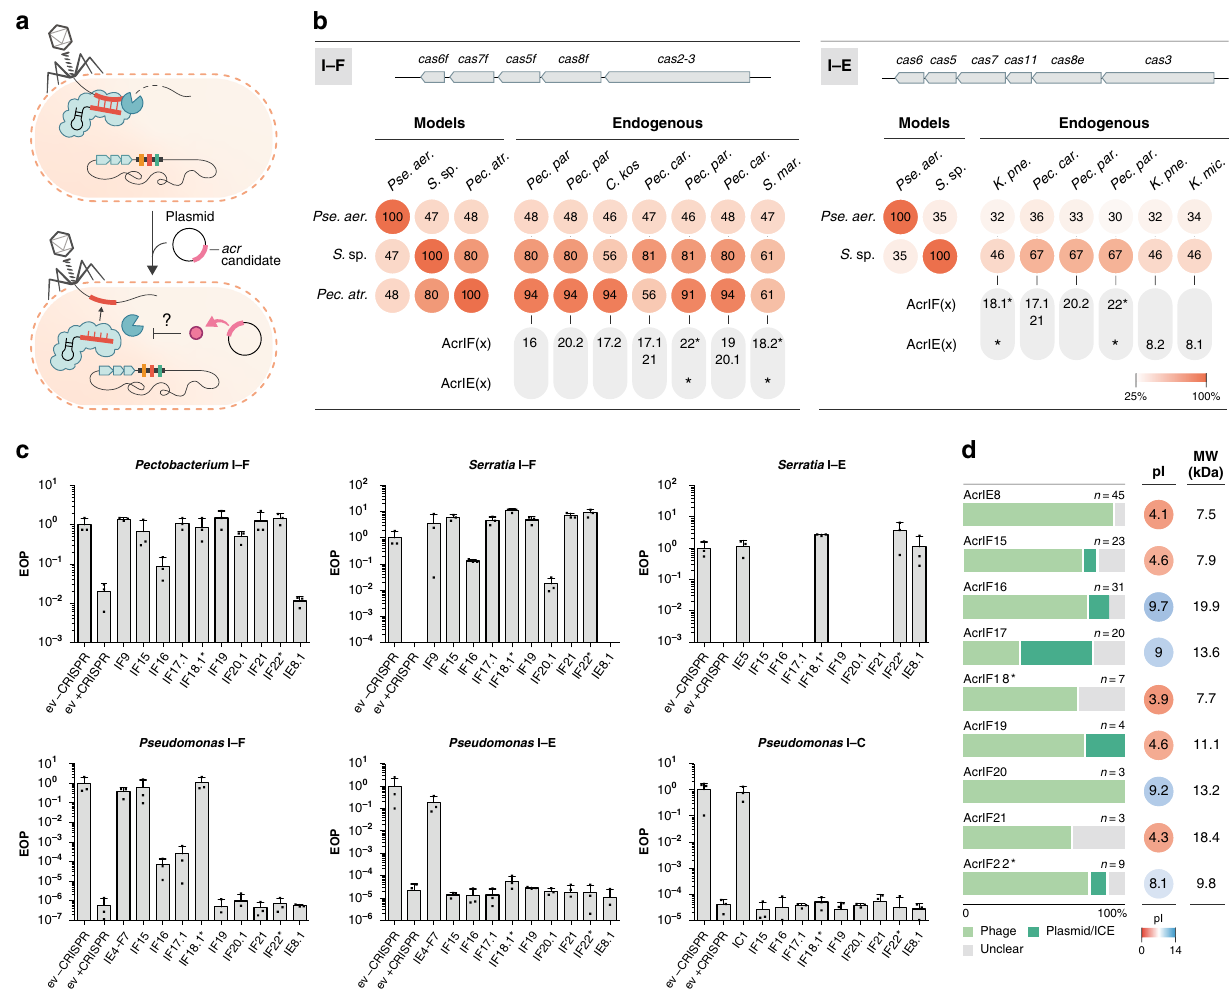
Fig. 2 Newly identi fi ed acr genes inhibit diverse type I CRISPR – Cas systems. a Schematic of the experimental setup employed for acr validation. Bacteria carrying their native type I – F, I – E, or I – C CRISPR – Cas systems and a plasmid expressing each acr candidate were challenged with a CRISPR-targeted phage and infectivity was assessed. b Percent sequence identity comparison between the model CRISPR – Cas systems challenged (type I – F: Pectobacterium , Serratia , and Pseudomonas ; type I – E: Serratia and Pseudomonas; type I – C: Pseudomonas ) and the type I – F/I – E systems found in the endogenous hosts of the acr candidates, when available. Average values for the individual percentage identity comparisons between Cas orthologs forming the type I – E/I – F interference complexes are shown, excluding the adaptation modules (see top gene map) (Supplementary Data 3). The speci fi c Acr orthologs found in the genomes which were selected for testing are noted below; asterisks indicate dual anti-I – F/I – E function. c Ef fi ciency of plaquing (EOP) of CRISPR-targeted phages in bacterial lawns expressing the different acr candidates, or the empty vector control (ev + CRISPR), compared to EOP of the same phage in non- targeting bacterial lawns carrying the empty vector (ev − CRISPR). Positive controls for Acr inhibition include AcrIF9 ( Pectobacterium and Serratia I – F), AcrIE5 ( Serratia I – E), AcrIE4-F7 ( Pseudomonas I – F and I – E), and AcrIC1 ( Pseudomonas I – C). Data are presented as mean ± SEM ( n = 3